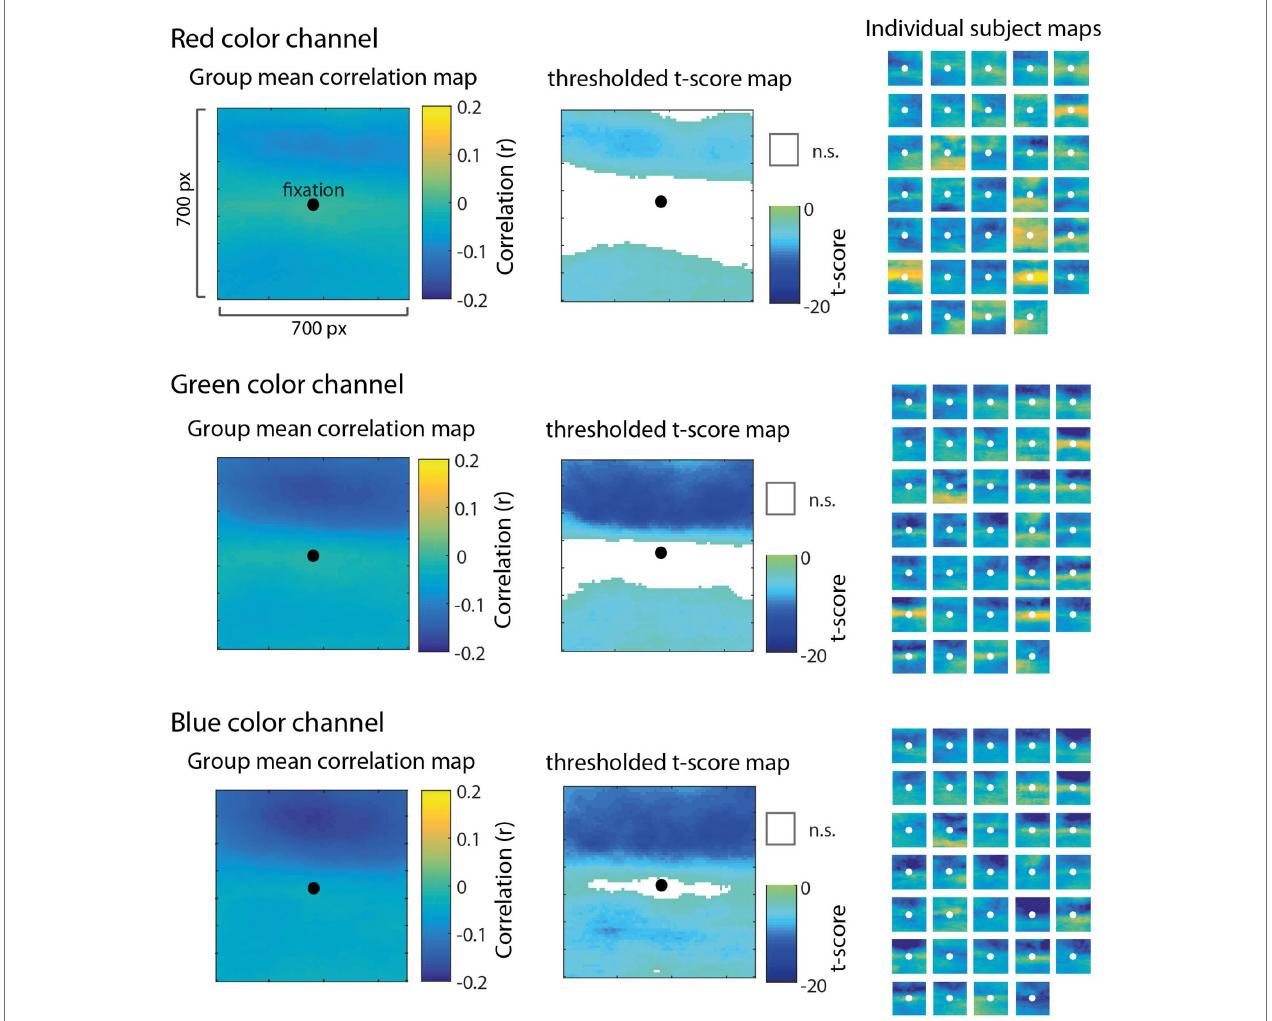
FIGURE 3 | Results of the correlation map analysis for the red (top row), green (middle row), and blue (bottom row) channels, illustrating the correlation between fluctuations in pupil size and pixel intensity in a 700 × 700 pixel square region surrounding fixation. Group mean correlation maps (left) are shown with a black circle as a reference to indicate the center of gaze. We computed the t -score on Fisher Z-transformed correlation values for each pixel to derive statistical maps (center) and applied a false discovery rate threshold (FDR = 0.01) with non-significant pixels (n.s.) represented as white. Individual maps for each of 34 subjects (right) are shown to visually inspect the consistency of results across